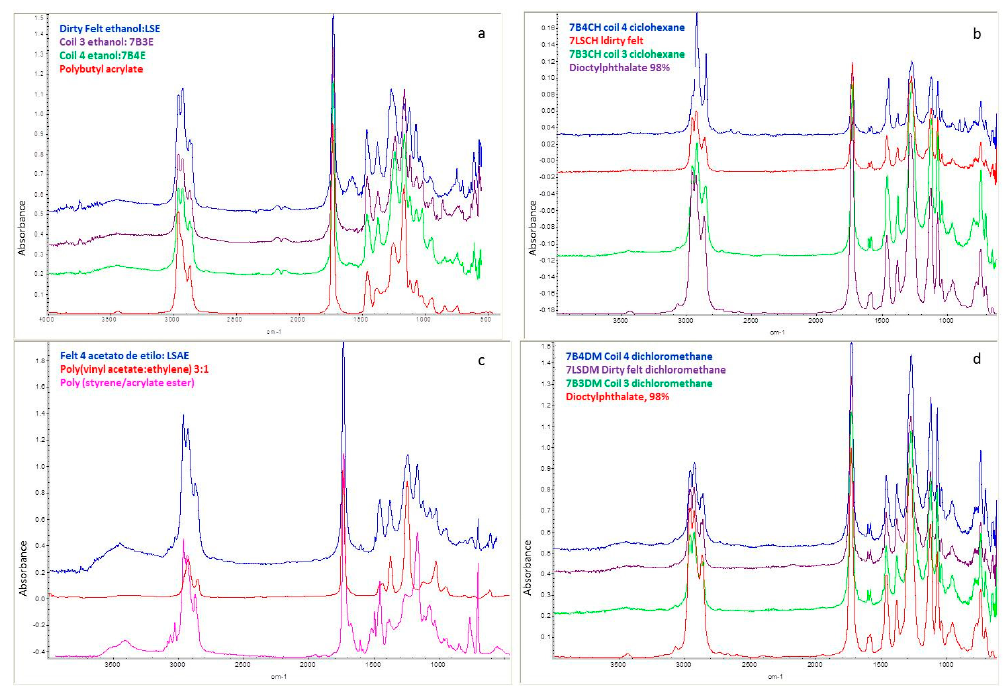
Figure 2. Comparison of the FTIR spectra of the different fractions of 7B3, 7B4, and 7LS. ( a ) Ethanol extraction; ( b ) cyclohexane; ( c ) ethyl acetate; ( d ) dichloromethane.